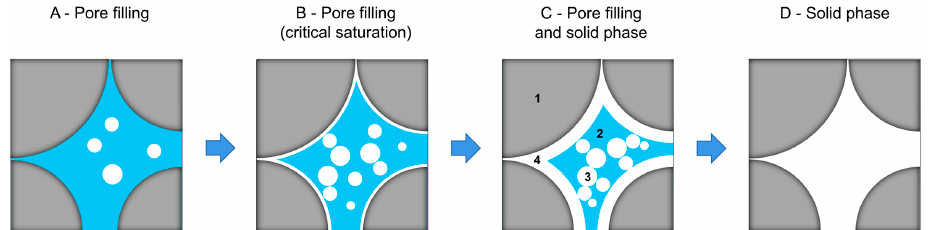
Figure 1. Schematics representations of various occurrence statuses ( A – D ) of gas hydrates. 1—Solid frame composed of minerals. 2—Water. 3—Gas hydrates as pore fillings. 4—Gas hydrates as part of the solid frame.